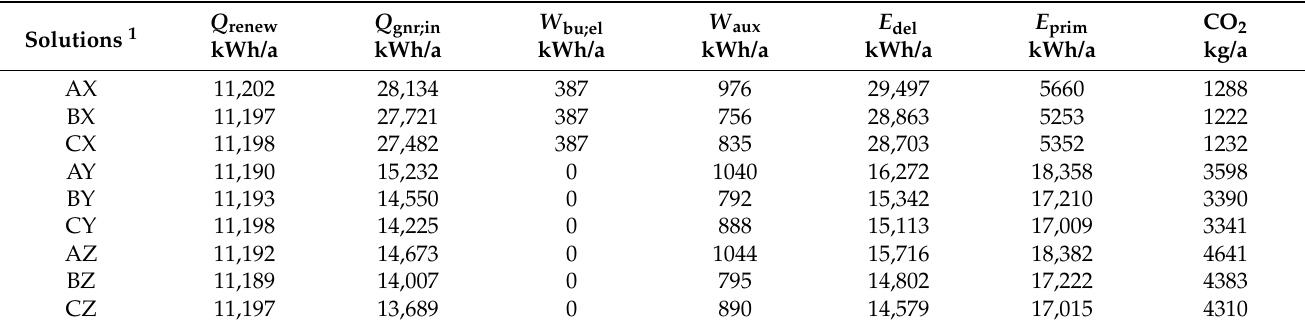
Table 7. Energy flow data and CO 2 emissions of cost-optimal system solutions for analyzed combina- tion of space emitters and boilers.